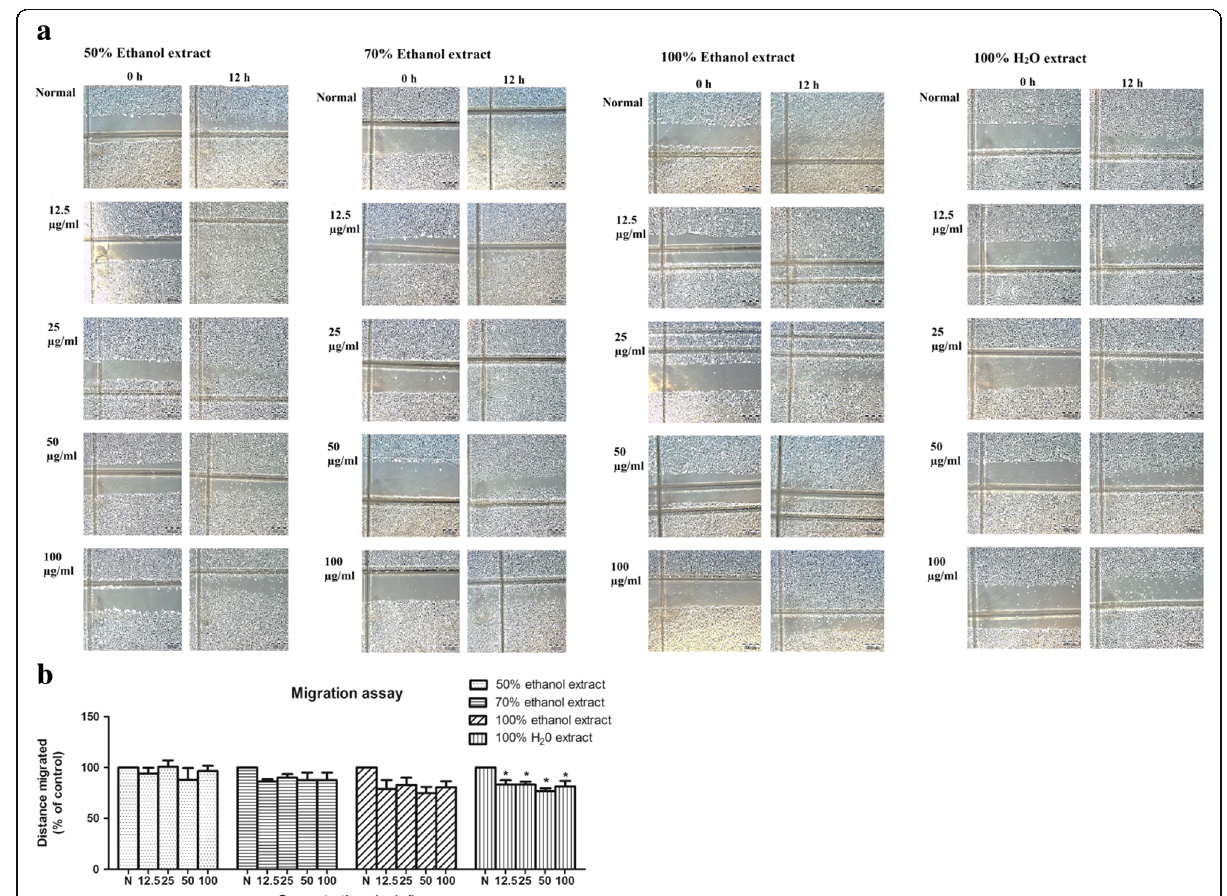
Fig. 3 Effects of 50, 70 and 100% ethanol extracts and 100% water extract of C. nutans leaves on cell migration. a Anti-migratory effects of 50, 70, 100% ethanol extract and 100% water extract of C. nutans leaves. Representative width was photographed. b Water extract of C. nutans leaves is capable to reduce HUVEC migration rate. The values presented are the mean ± SEM of three independent experiments and compared against normal control (N). * p < 0.05 were considered